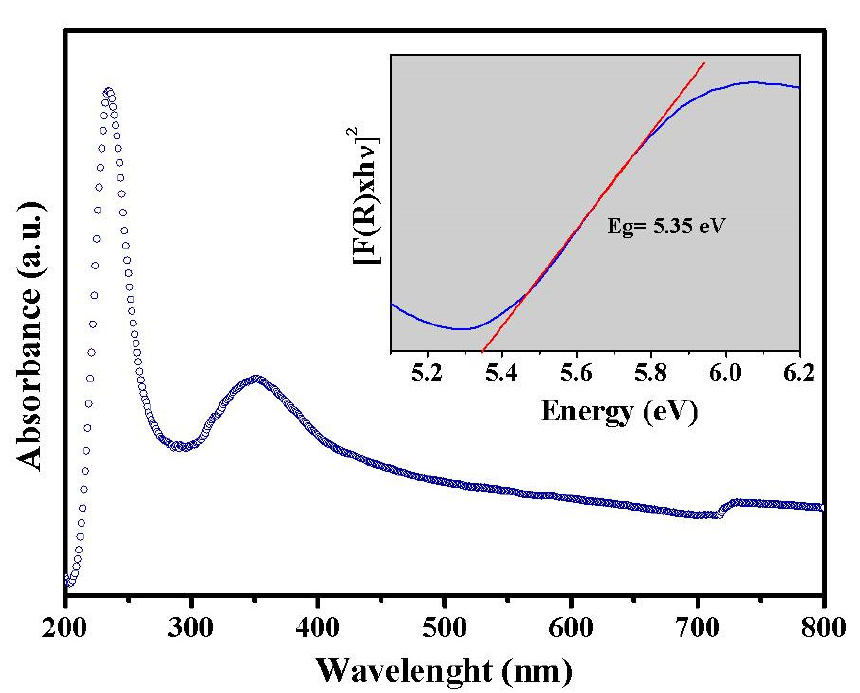
Figure 4. UV-Vis absorbance and DRS spectra of Ga-HAp. Figure 4. UV ‐ Vis absorbance and DRS spectra of Ga ‐ HAp.